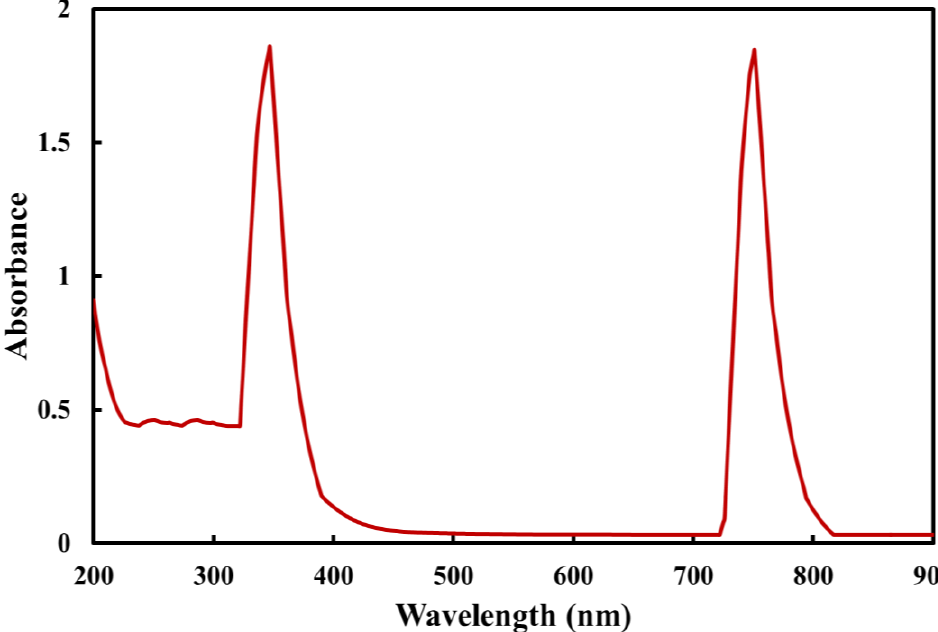
Figure 2. UV spectrum of Co 3 O 4 NPs synthesized using rosemary leaf extract.